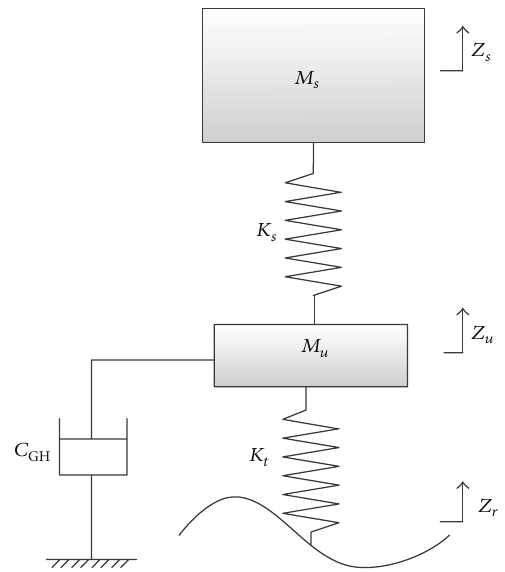
Figure 3: Quarter-vehicle SAS system with GH approach.